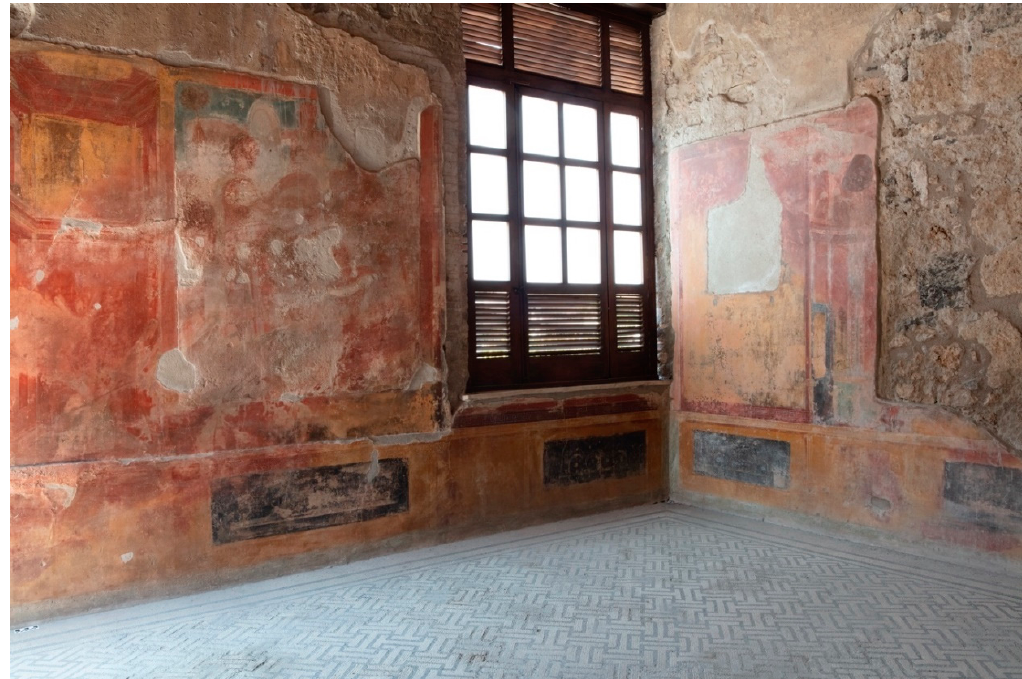
Figure 9. Room 16, north wall. Image Courtesy: Kelly McClinton 2017, on concession of the Ministero dei Beni e delle Attività Culturali e del Turismo, Parco Archeologico di Pompei (used by permission).